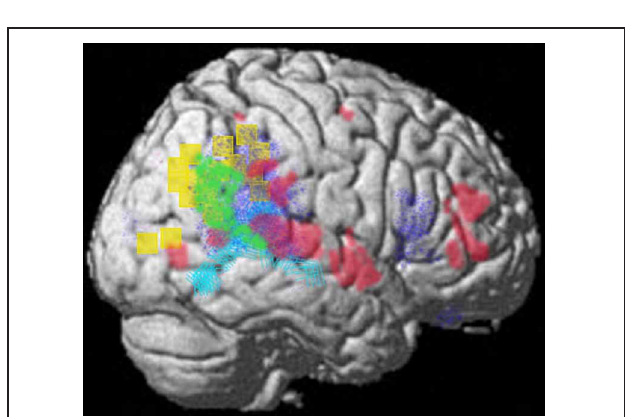
unofficial adaptation or translation of an article that appeared in a publication of the American Physiological Society. The American Physiological Society has not endorsed the content of this adaptation or translation, or the context of its use.